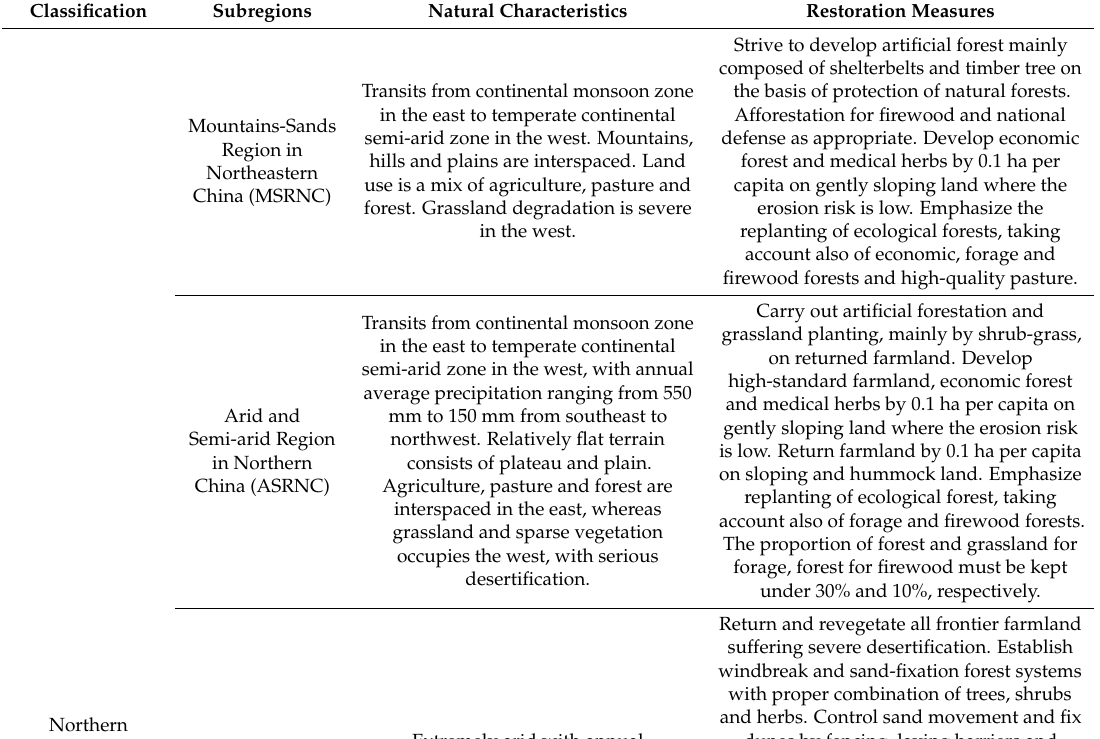
Table 1. Natural characteristics and restoration measures in the Grain for Green Program (GGP)